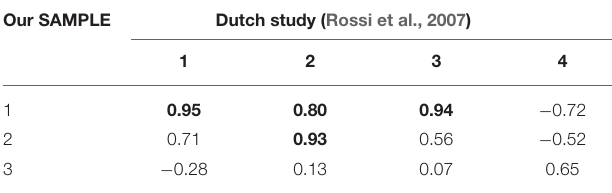
TABLE 11 | Coefficients of congruence ( 8 ) between factors of our sample and the Dutch study (Rossi et al., 2007), using the structure matrix. Our SAMPLE